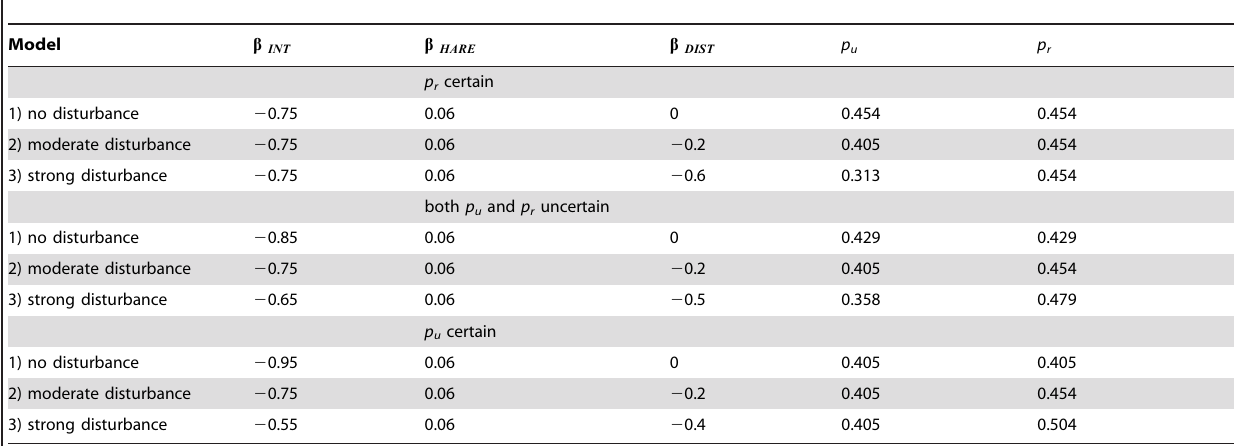
Table 2. Parameter values of alternative models and assumptions.